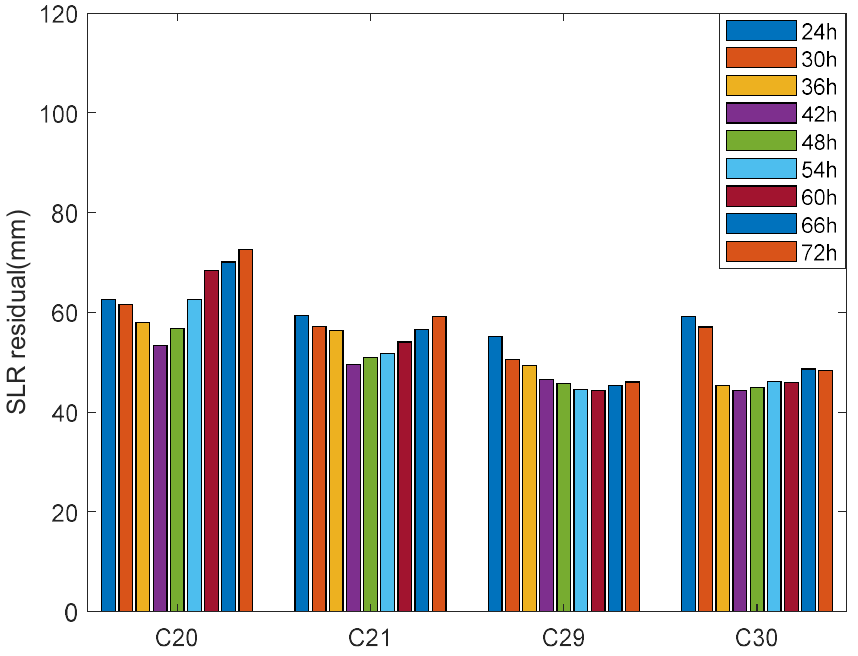
Figure 3. SLR residuals for BDS-3 MEO satellites with different arc lengths.